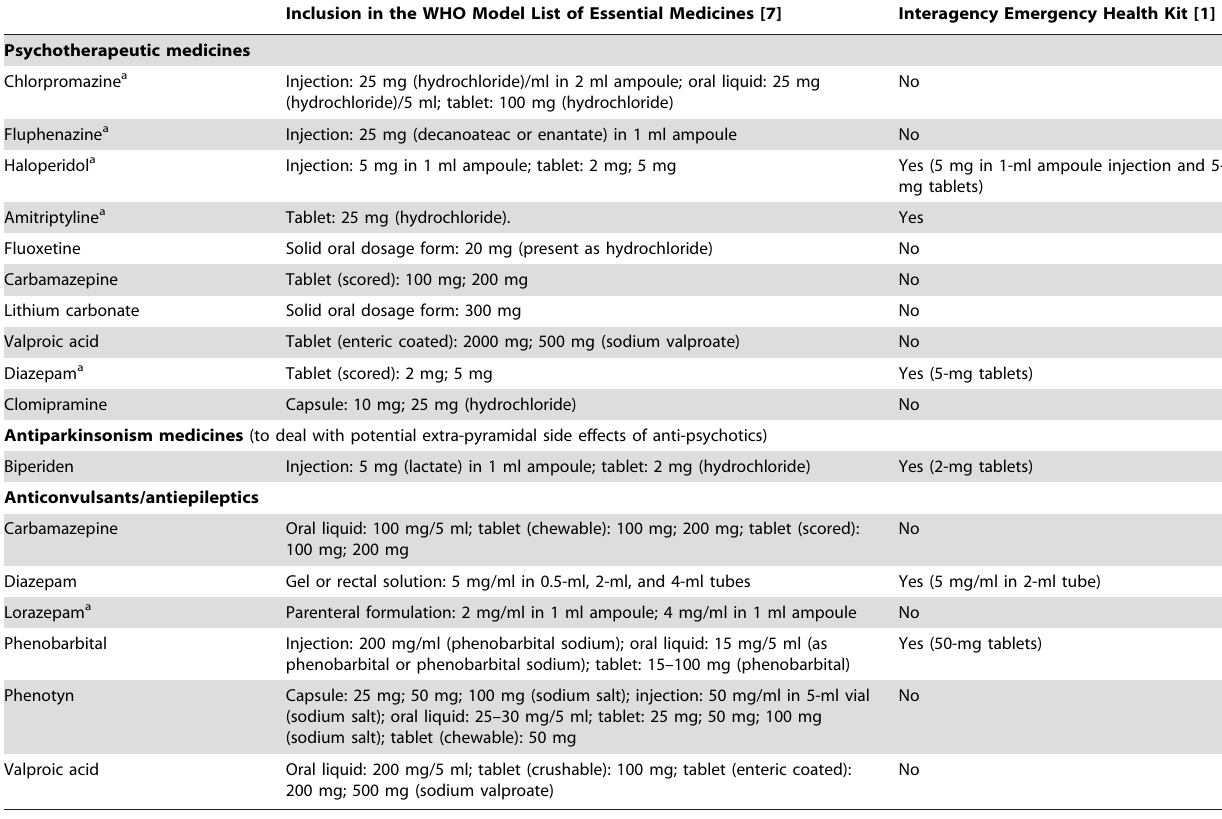
Inclusion in the Next Edition of the Interagency Emergency Health Kit [1]